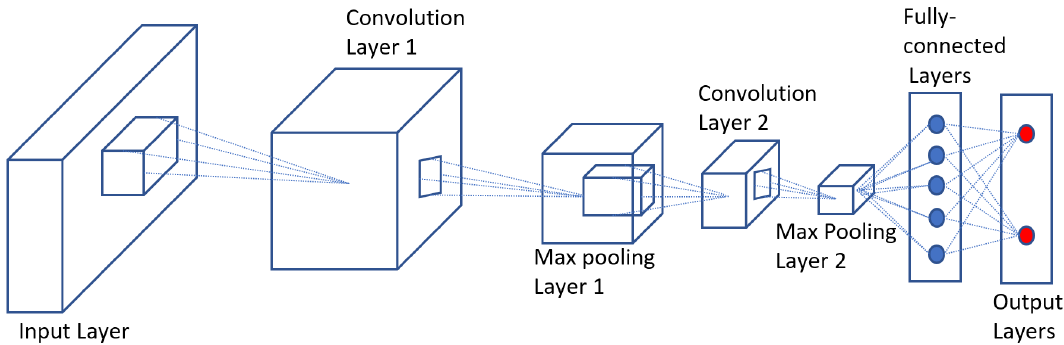
Figure 3. Convolutional neural network (CNN)